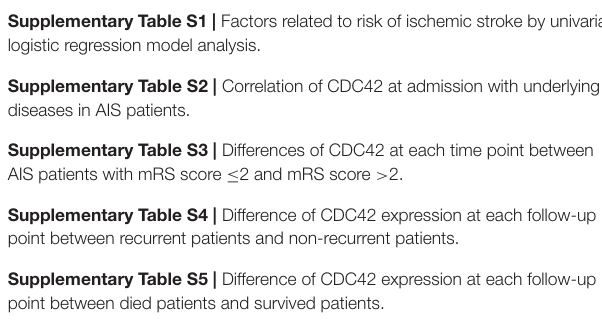
Supplementary Figure S1 | Acute ischemic stroke (AIS) patients with different subtypes showed no difference in Cell division cycle 42 (CDC42). Supplementary Figure S2 | Comparison of CDC42 in AIS patients with different disease severity. Supplementary Figure S3 | Comparison of CDC42 to admission vs. 3 days, and 3 days vs. 3 years in patients with AIS. Supplementary Figure S4 | CDC42 was correlated with recurrence risk in patients with AIS. The correlation of CDC42 at admission (A) , 1 day (B) , 3 days